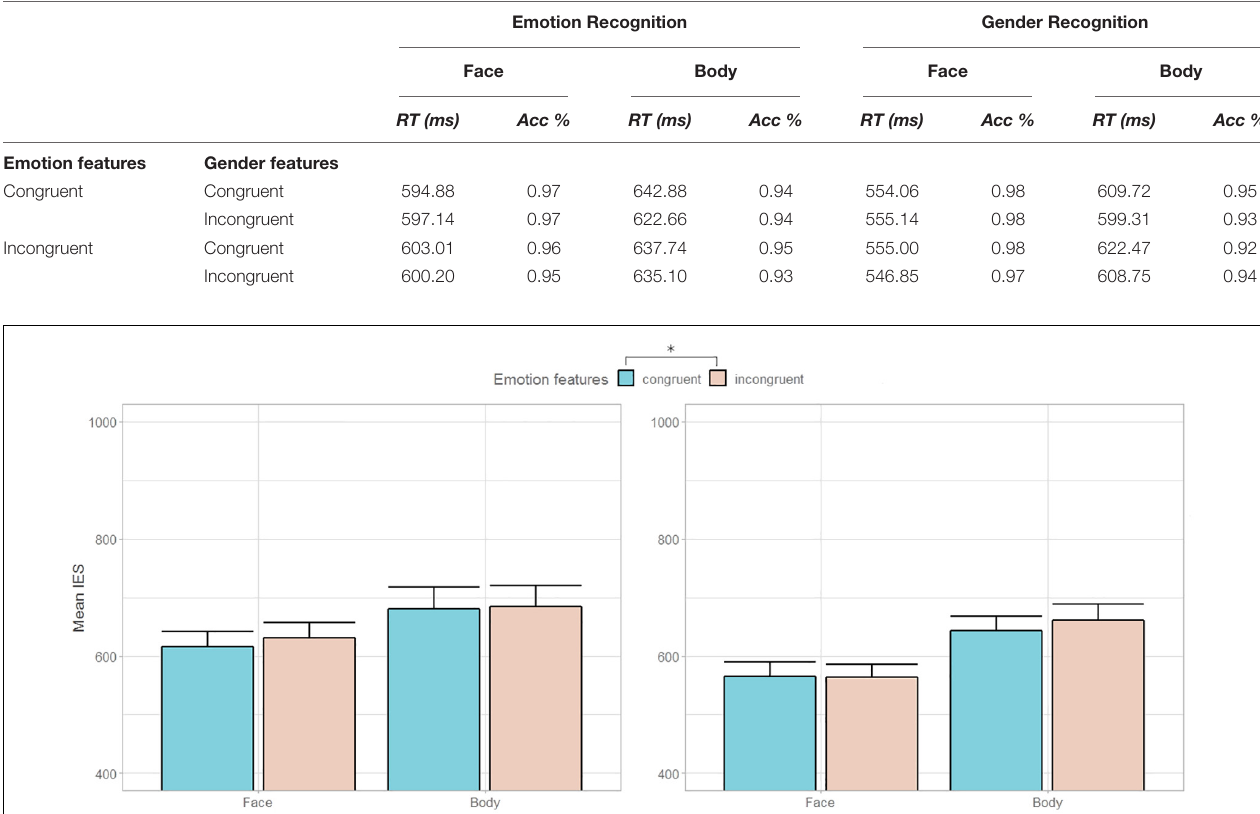
TABLE 1 | Mean RTs and Accuracy for each experimental condition in Experiment 1.